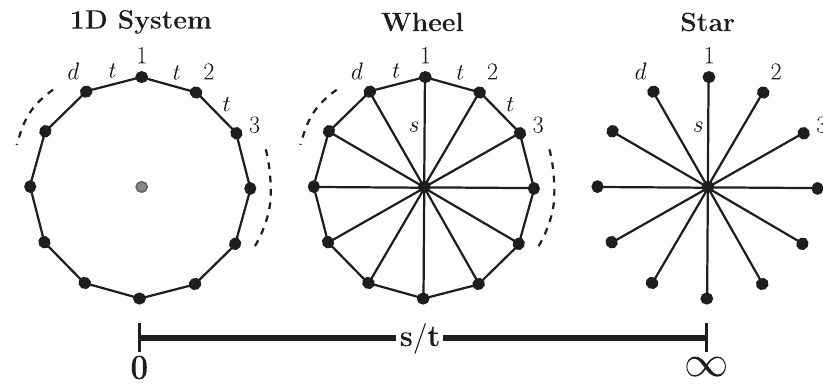
Fig. 1 Topology of the lattice. An interpolation between the 1 D regime and the “ star ” through the “ wheel